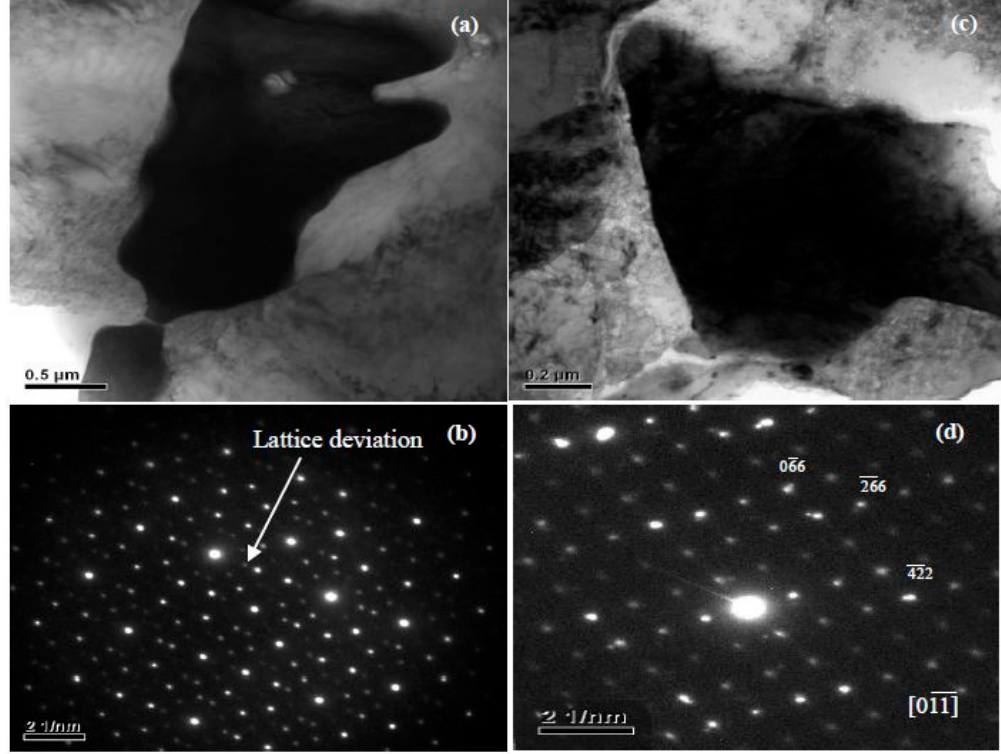
Figure 4. Identification of I-phase with dendritical shape by transmission electron microscopy (TEM) in Mg-5Zn-0.278Gd alloy (Sample 10): ( a ) bright field (BF) image, ( b ) five-fold axes selected area electron diffraction (SAED) pattern, there exists some lattice deviations as pointed with white arrow which means the liner phason strain in I-phase. The I-phase has a composition of approximate Mg 30 ± 1 Zn 62 Gd 8 ± 1 (at.%) and is identified to have point group symmetry m 35, which is inconsistent with lattice transitions. Identification of W/-phase with triangular shape by TEM in Mg-5Zn-0.278Gd alloy (Sample 10): ( c ) BF image, ( d ) SAED pattern along [ 011 ] zone axis. The W / -phase has a composition of approximate Mg 94±1 Zn 5.47±0.5 Gd 0.53±0.1 (at.%) and is identified to have a face centered cubic (fcc) structure with a lattice parameter of a = 2.3529 nm.